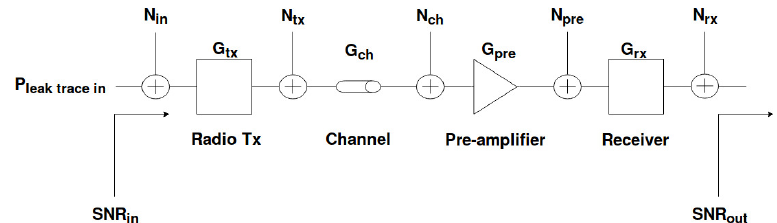
Figure 8: Simple model of the transmission chain between target and